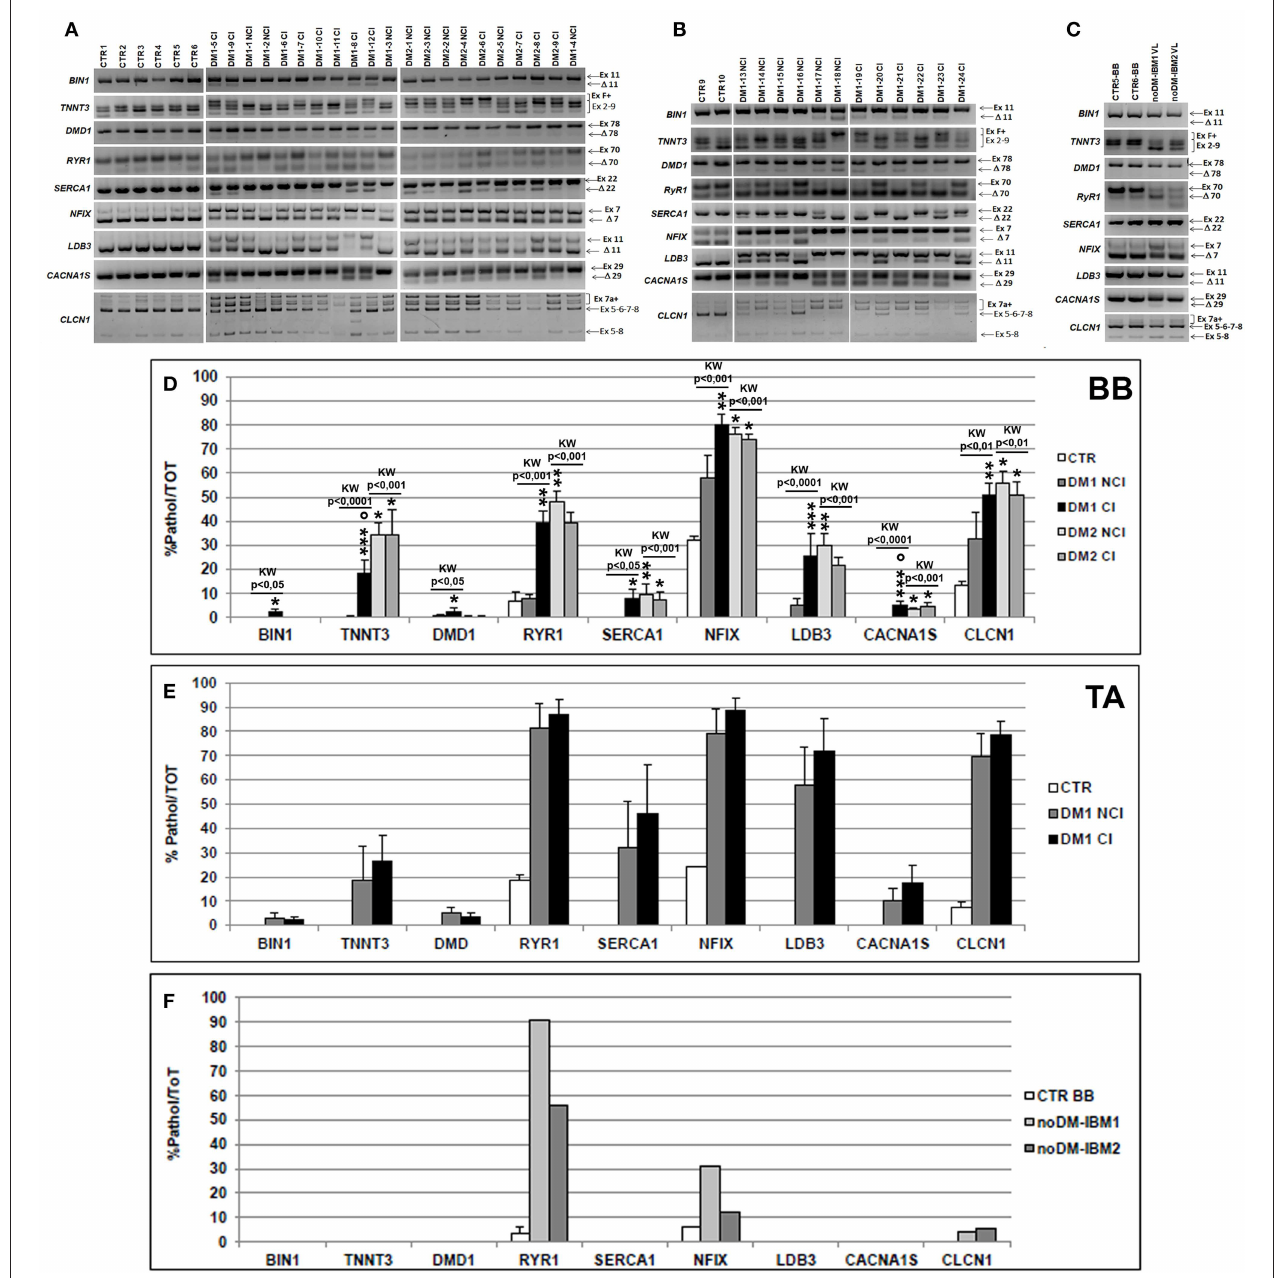
FIGURE 4 | (A–C) Alternative splicing of muscle-specific genes in skeletal muscle. Panels showing the reverse transcriptase-polymerase chain reaction (RT-PCR) splicing assay of BIN1 , TNNT3 , DMD , RYR1 , SERCA1 , NFIX , LDB3 , CACNA1S , and CLCN1 genes in biceps brachii (BB) (A) and tibialis anterior (TA) muscle samples (B) from CTR, DM1, and DM2 patients. DM1 and DM2 patient groups have been divided into two subgroups according to the presence of cardiac abnormalities: NCI, no cardiac involvement; CI, cardiac involvement. Alternative splicing of the muscle-specific genes has been analyzed in vastus lateralis of patients affected by inclusion body myositis (noDM-IBM) (C) . The products that include the specific (Ex) and those that exclude the specific exon ( 1 ) have been indicated. Analysis of the percentage of altered isoforms expression in BB (D) , TA (E) , and in noDM-IBM muscle samples (F) . Histograms represent mean values and bars represent SEM. GAPDH has been chosen as the housekeeping, internal control. Each PCR reaction has been performed in triplicate. The differences between subgroups have been assessed by nonparametric, Kruskal–Wallis test. Results from Dwass, Steel, Critchlow–Fligner multiple post-hoc comparison procedure: NCI or CI subgroups vs. CTR, * p < 0.05, ** p < 0.01; NCI vs. CI, ◦ p <